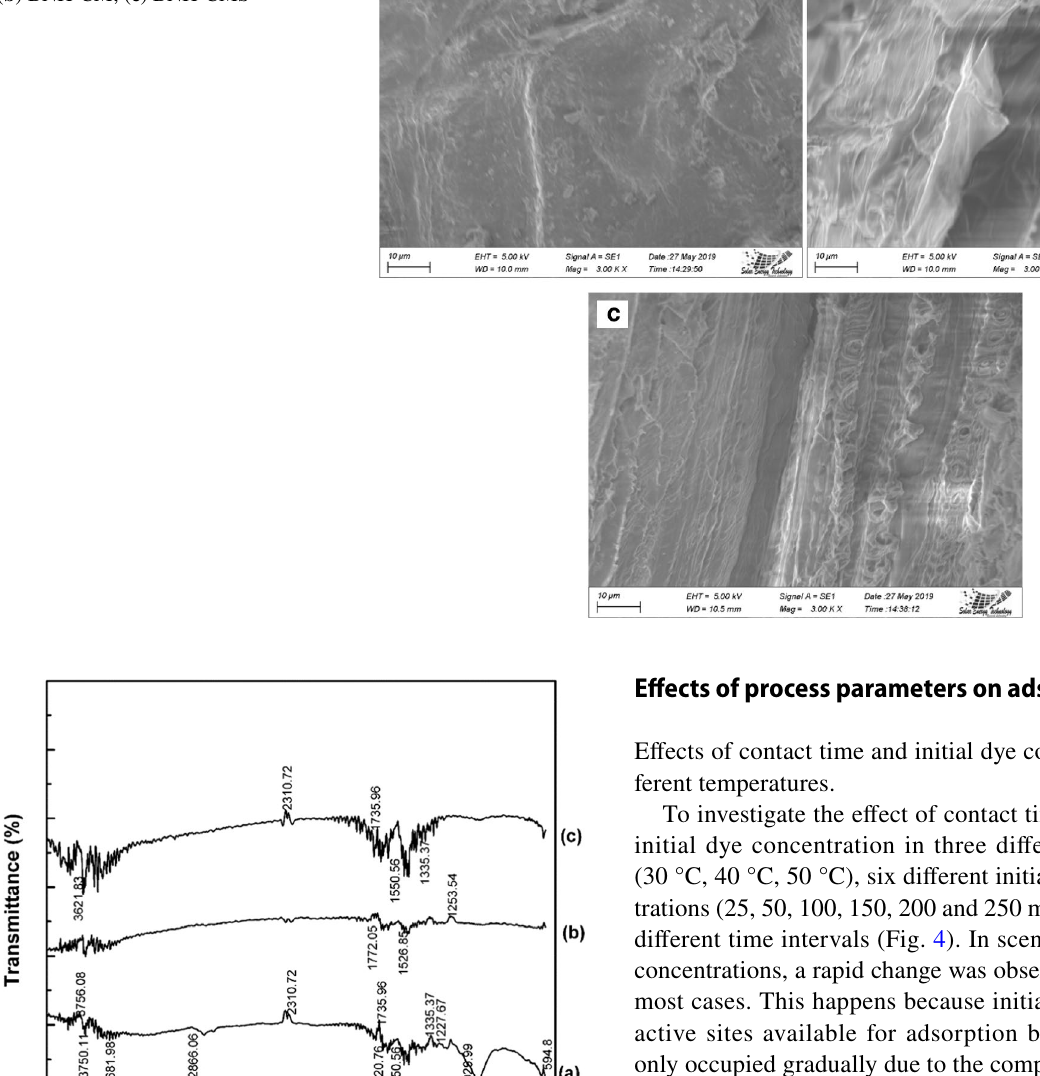
Fig. 2 SEM images of ( a )